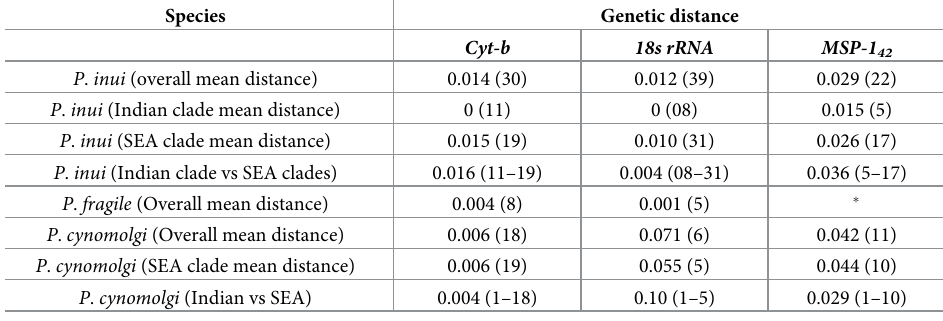
Table 3. Genetic divergences (substitutions per site) among different Plasmodium s pecies using the Kimura 2-Parameter model as implemented in MEGA v5.2.2 [45]. Species Genetic